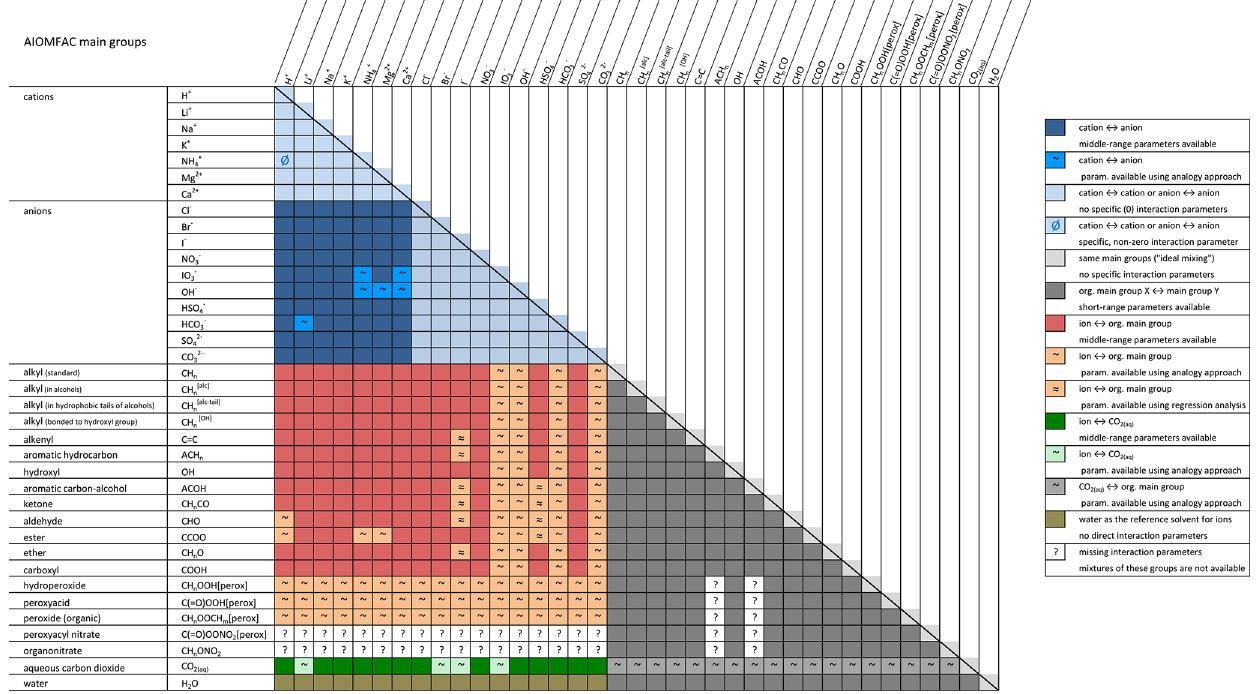
Figure 1. Revised AIOMFAC interaction matrix indicating available and missing binary interaction parameters. Parameters available based on regression analysis are depicted by symbol ( ≈ ); those based on substitution are depicted by symbol ( ∼ ). Figure adapted based on original Fig. 4 from https://aiomfac.lab.mcgill.ca/about.html (last access: 5 November